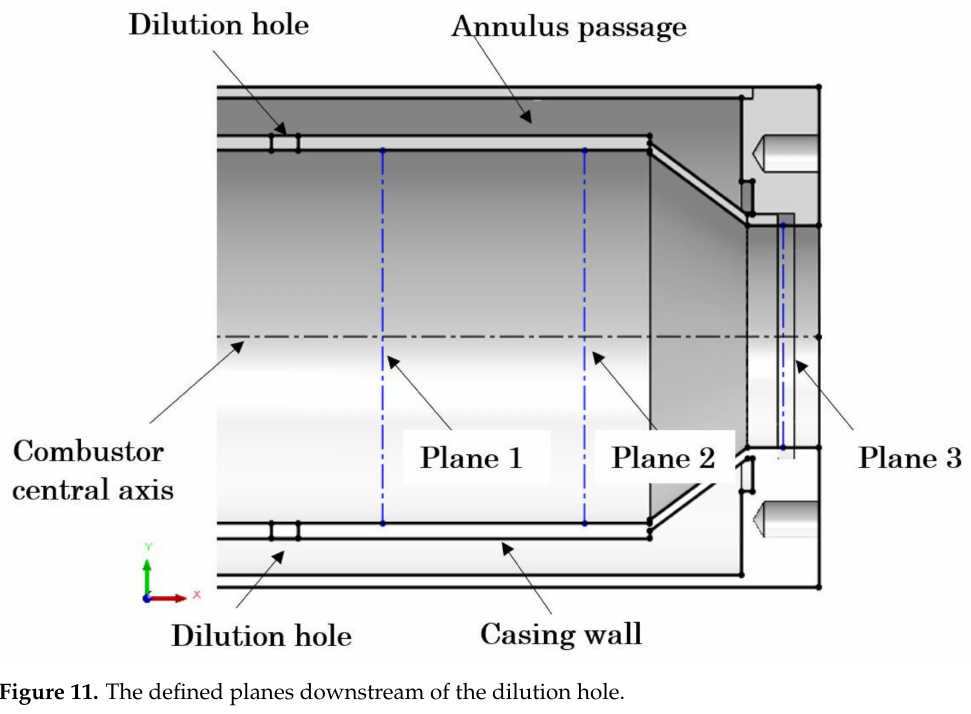
Figure 11. The defined planes downstream of the dilution hole.